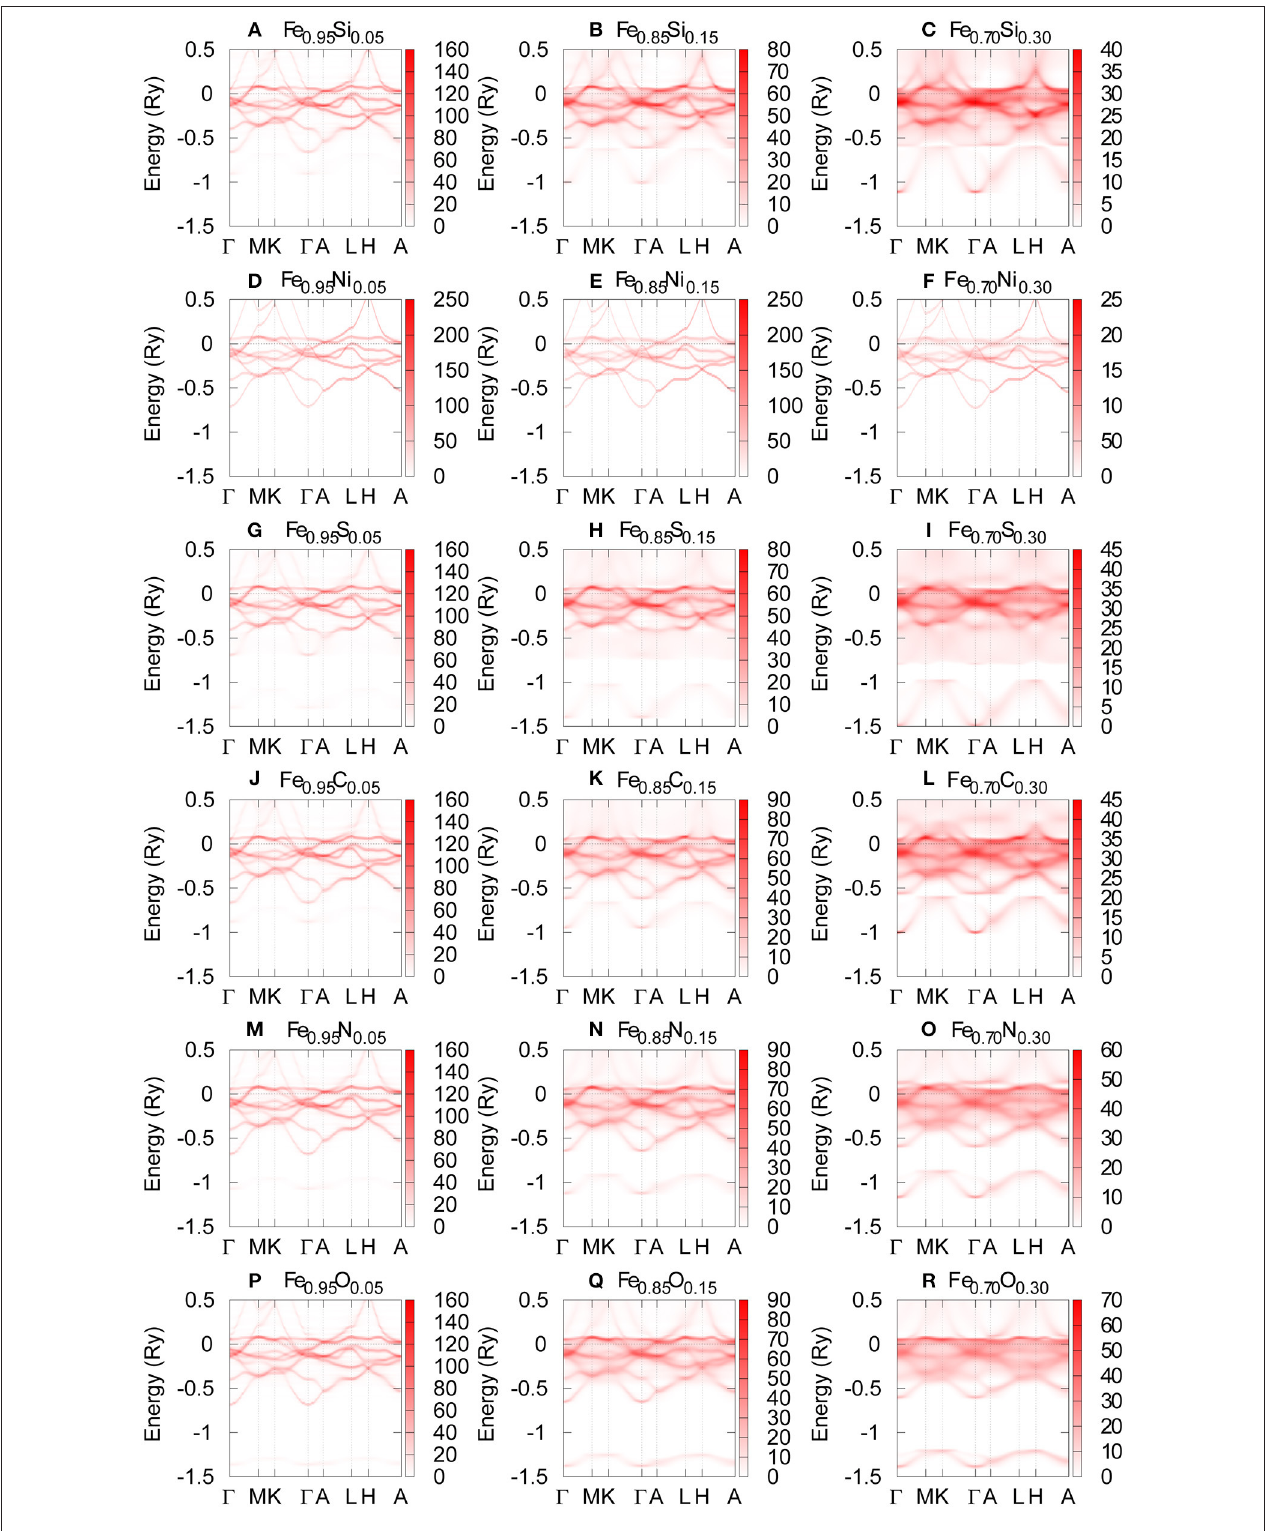
FIGURE 4 | The band structure of hcp Fe-based alloys with the volume of 19.10 Å 3 ( ∼ 40 GPa). The Fermi energy is set to be 0 Ry. The compositions are (A) Fe 0.95 Si 0.05 , (B) Fe 0.85 Si 0.15 , (C) Fe 0.70 Si0.30, (D) Fe 0.95 Ni 0.05 , (E) Fe 0.85 Ni 0.15 , (F) Fe 0.70 Ni 0.30 , (G) Fe 0.95 S 0.05 , (H) Fe 0.85 S 0.15 , (I) Fe 0.70 Si 0.30 , (J) Fe 0.95 C 0.05 , (K) Fe 0.85 C 0.15 , (L) Fe 0.70 C 0.30 , (M) Fe 0.95 N 0.05 , (N) Fe 0.85 N 0.15 , (O) Fe 0.70 N 0.30 , (P) Fe 0.95 O 0.05 , (Q) Fe 0.85 O 0.15 and (R) Fe 0.70 O 0.30 .